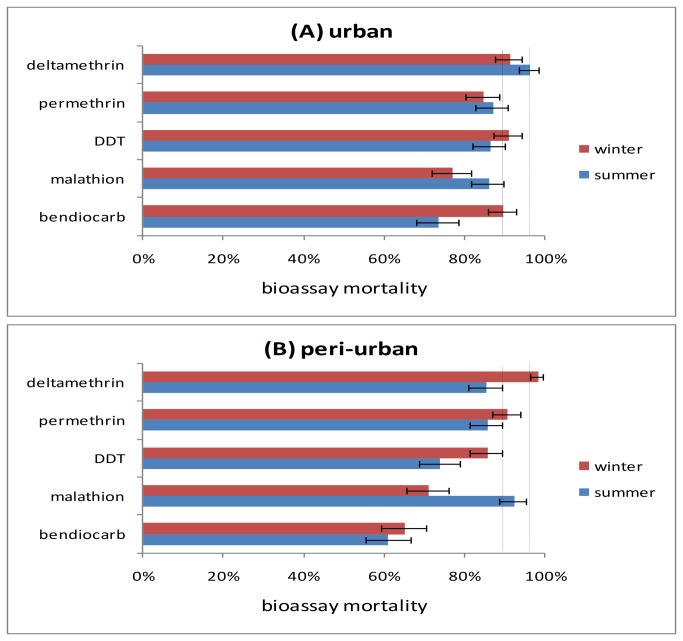
Insecticide resistance bioassay data pooled across sites for mosquitoes collected in each agricultural season in (A) urban and (B) peri-urban sites.Bars show mean mortality with 95% binomial confidence limits. Solid vertical lines show the WHO mortality threshold for definition of resistant mosquitoes; the dashed lines show the threshold for suspected resistance.